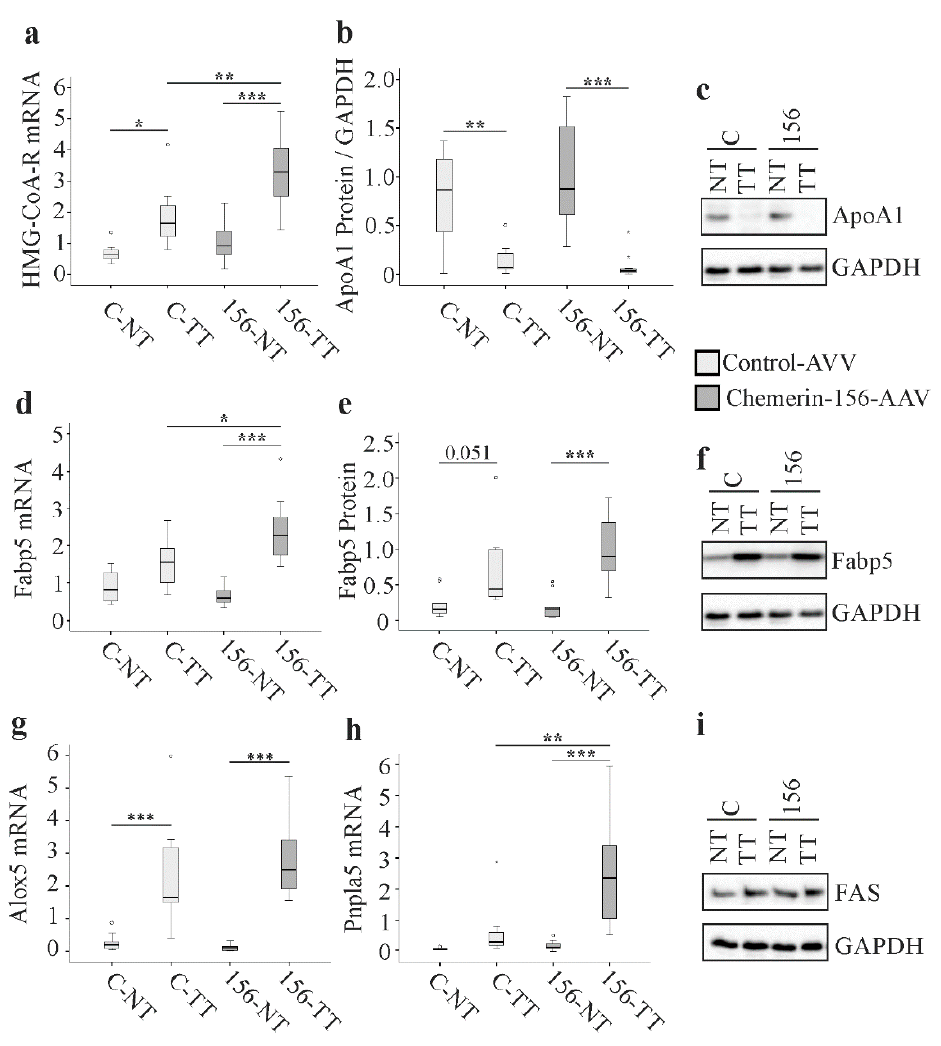
Figure 5. Levels of mRNA and protein for genes with a function in lipid metabolism in hepatic non-tumorous (NT) and tumor tissue (TT) of control-AAV (C) and chemerin-156-AAV (156) infected mice. ( a ) Expression of HMG-CoA-R mRNA. ( b ) Expression of ApoA1 protein. ( c ) Representative immunoblot of ApoA1 protein in NT and TT of both groups. ( d ) Expression of Fabp5 mRNA. ( e ) Expression of Fabp5 protein. ( f ) Representative immunoblot of Fabp5 protein in NT and TT of both groups. ( g ) Expression of Alox5 mRNA. ( h ) Expression of Pnpla5 mRNA. ( i ) Representative immunoblot of FAS protein in NT and TT of both groups. Small circles in the figure indicate outliers greater than 1.5 times the interquartile range and small stars indicate outliers greater than 3.0 times the interquartile range. * p < 0.05, ** p < 0.01, *** p < 0.001.